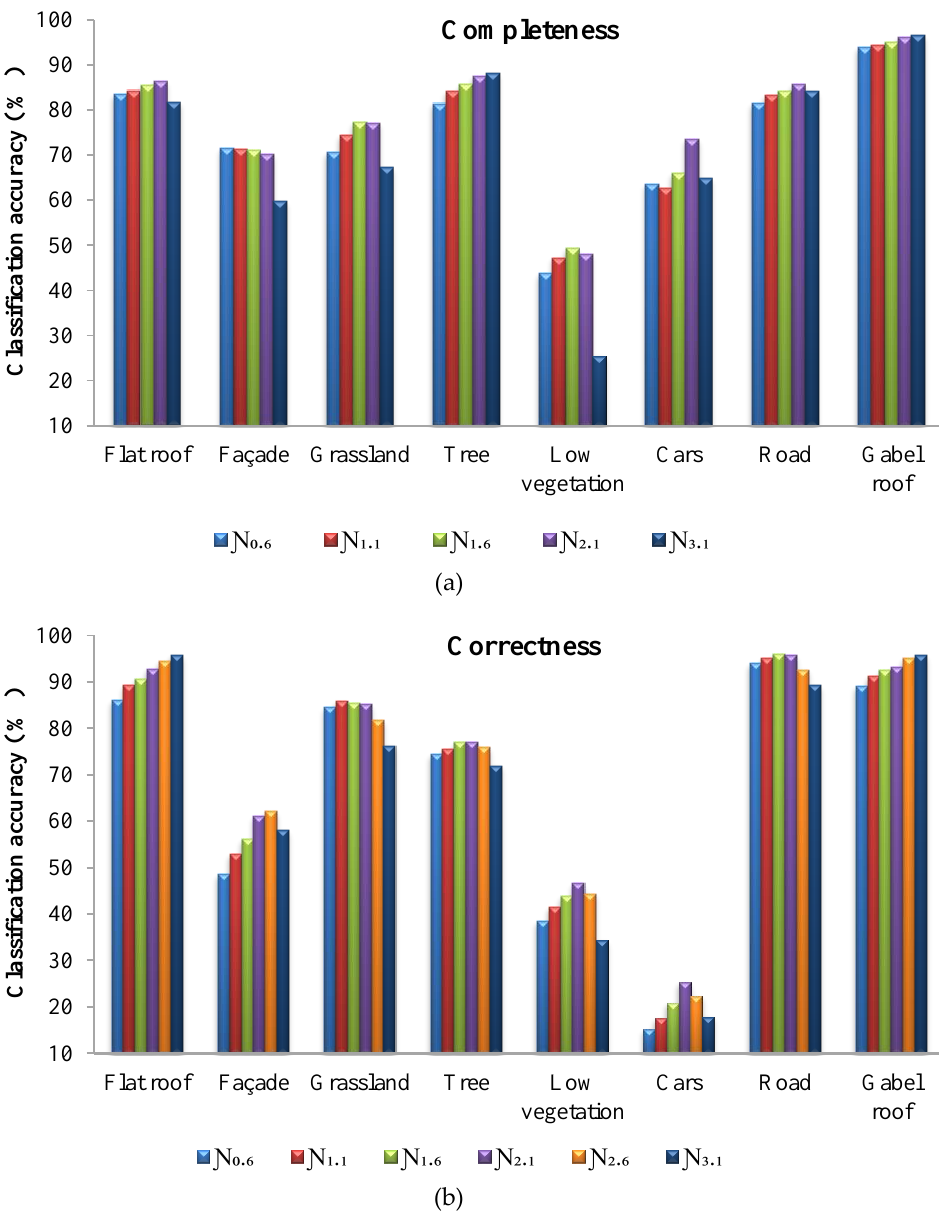
Figure 4. Completeness ( a ) and correctness ( b ) for all classes with different neighborhood sizes in combined Vaihingen sites.